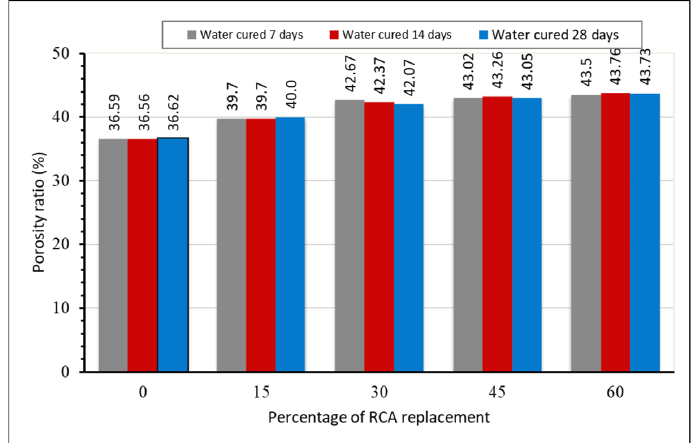
Figure 6. Porosity of porous